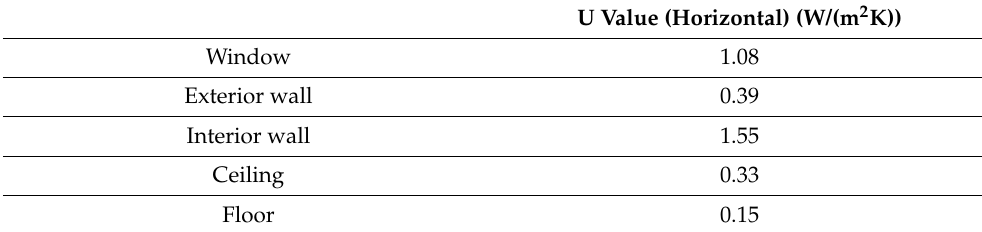
Table 4. U values of the construction.